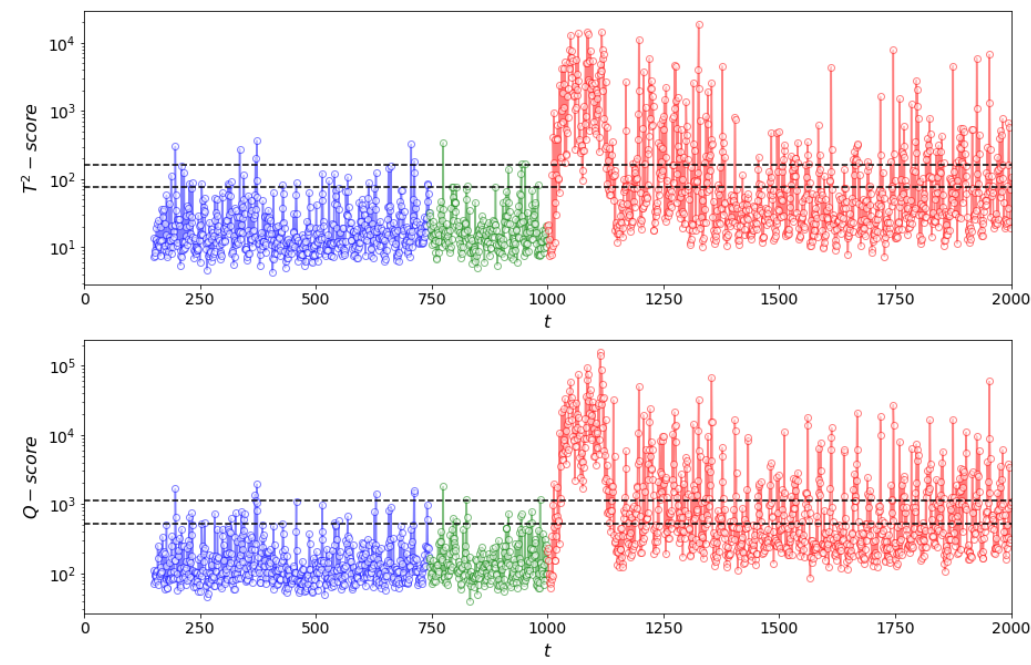
Figure 11. T 2 ( top ) and Q ( bottom ) process monitoring charts of simulated dataset for a window length of 150 time steps using Method I. NOC data are shown in blue (up to index 749), validation data in green (indices 750–999) and test (fault) data in red (indices 1000–2000).